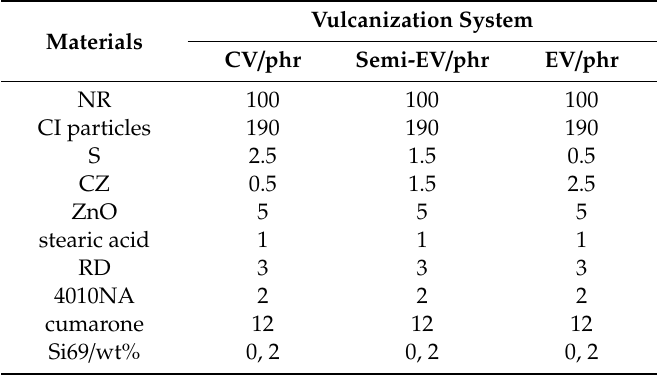
Table 1. Compositions of the magnetorheological elastomers (MRE) samples.